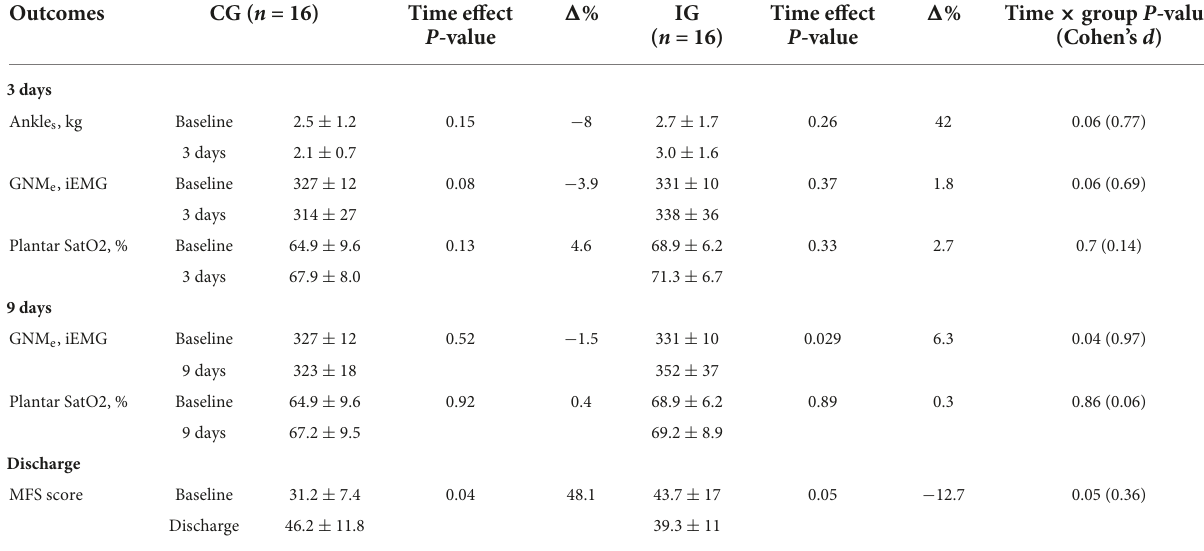
TABLE 2 Outcome comparison across time between both groups.